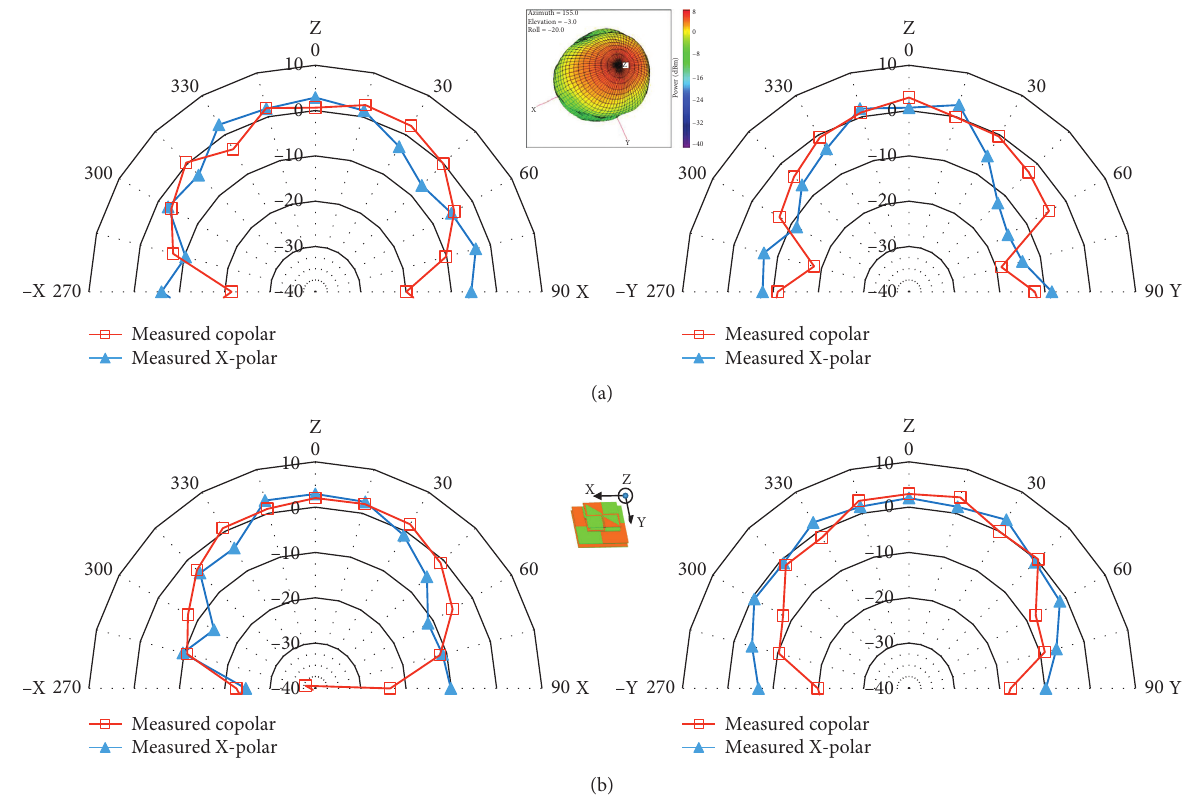
Figure 10: Measured radiation patterns when feeding on xz-plane and yz-plane at 1.575GHz: (a) port-1 and (b)